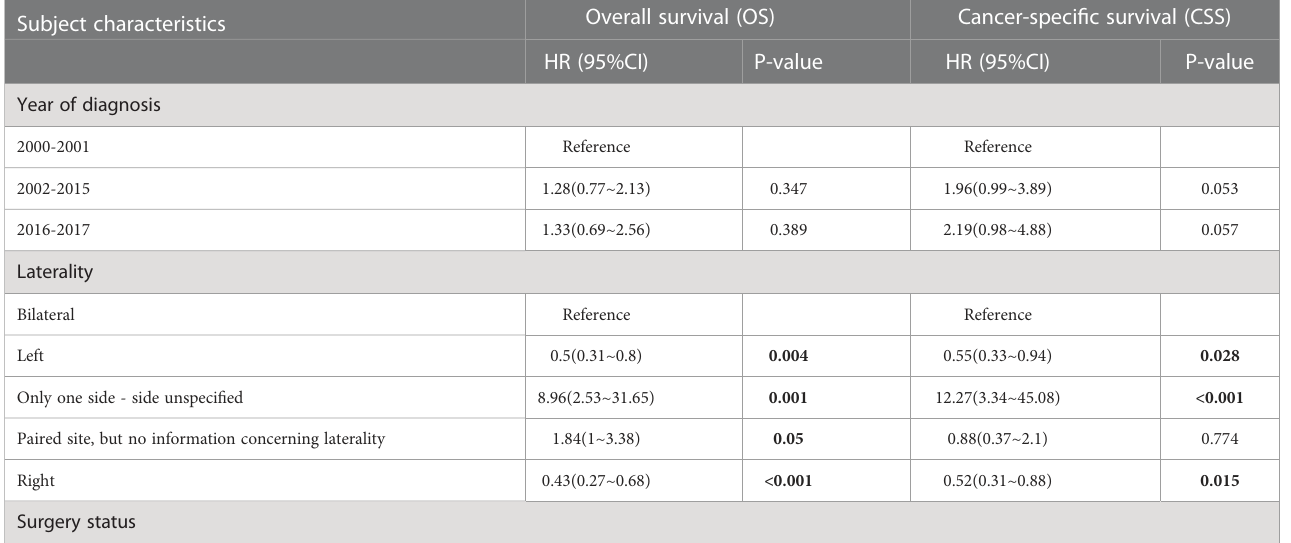
TABLE 2 Univariable Cox Regression for analyzing the associated factors for small cell carcinoma of the